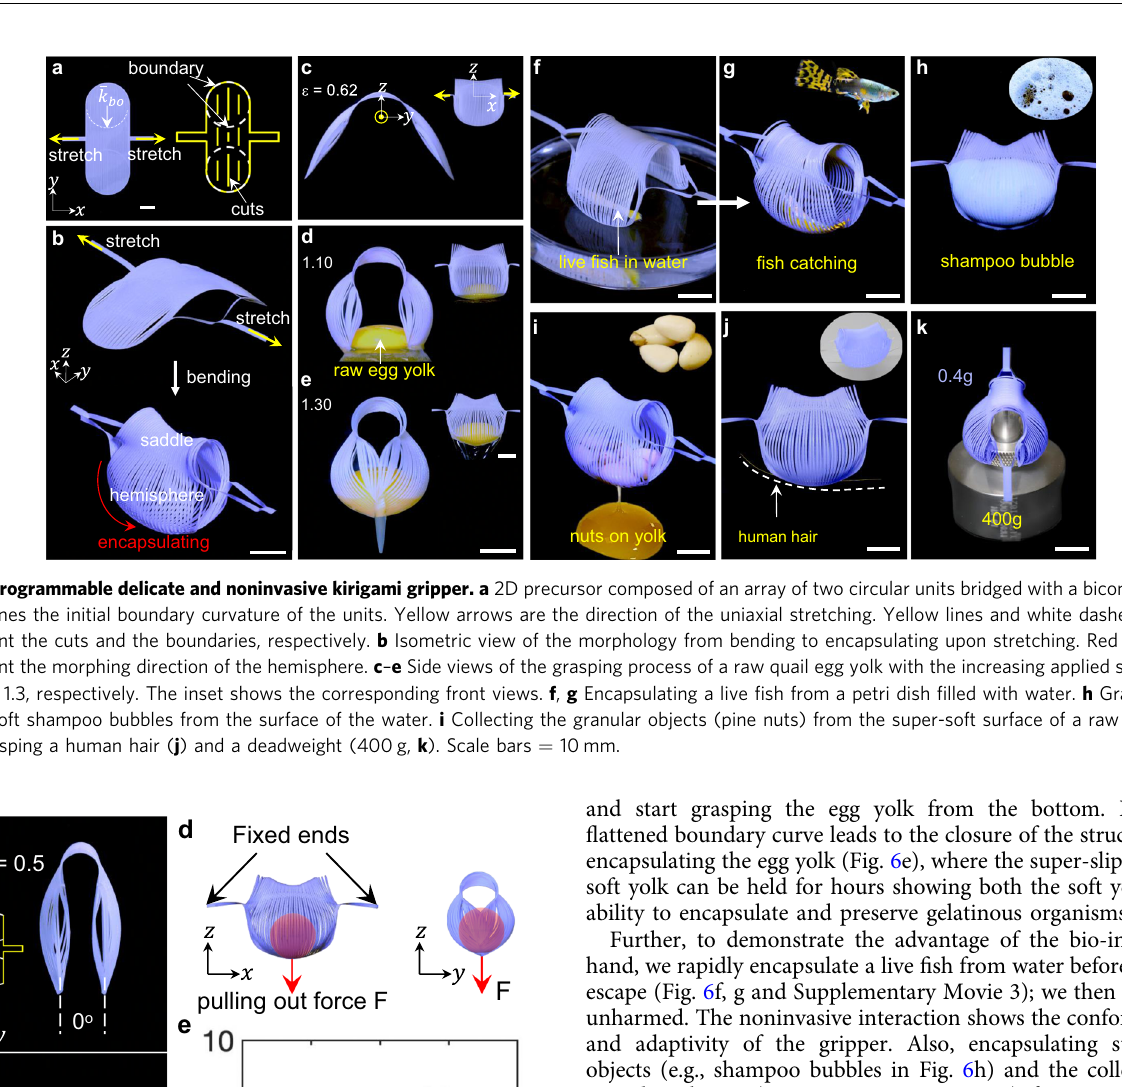
(cid:1) , it k bo < 1) to bo